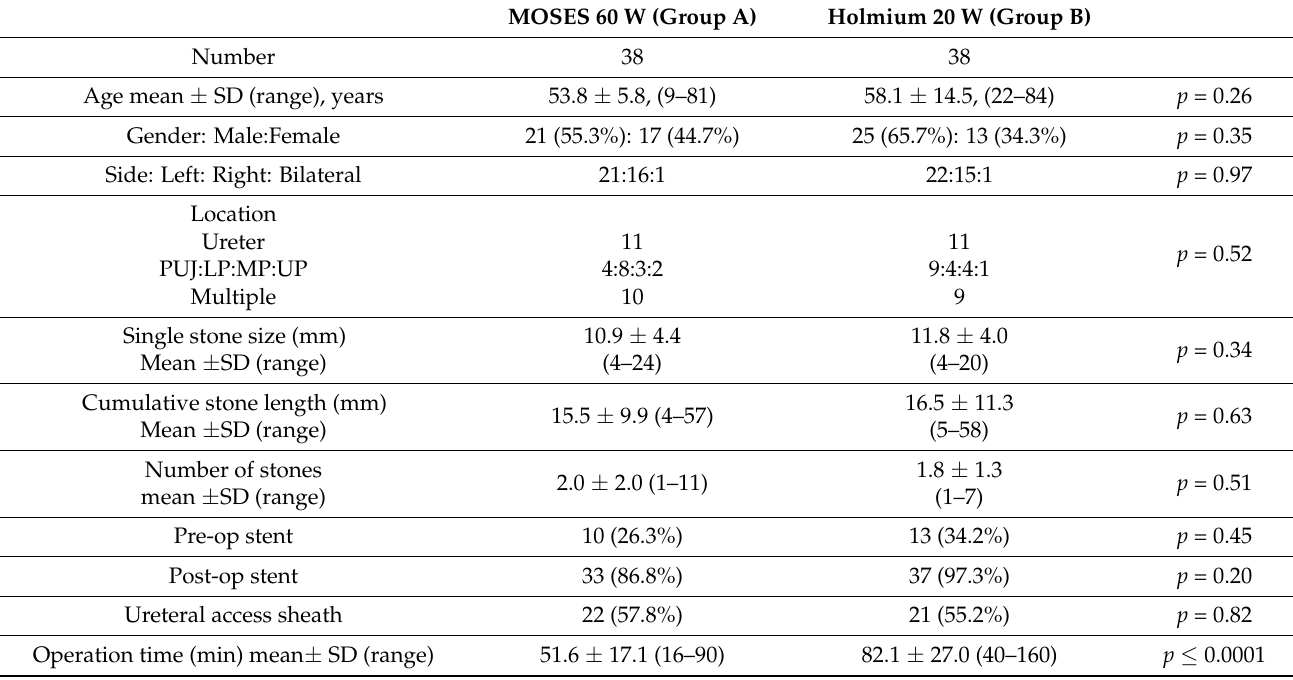
Table 1. Patient and procedural details (PUJ—pelviureteric junction, LP—lower pole, MP—mid pole, LP—lower pole, UA— uric acid, COM—Calcium oxalate monohydrate, COD—calcium oxalate dihydrate, CPC—calcium phosphate carbonate, CHP—calcium hydrogen phosphate dihydrate, MAH—magnesium ammonium